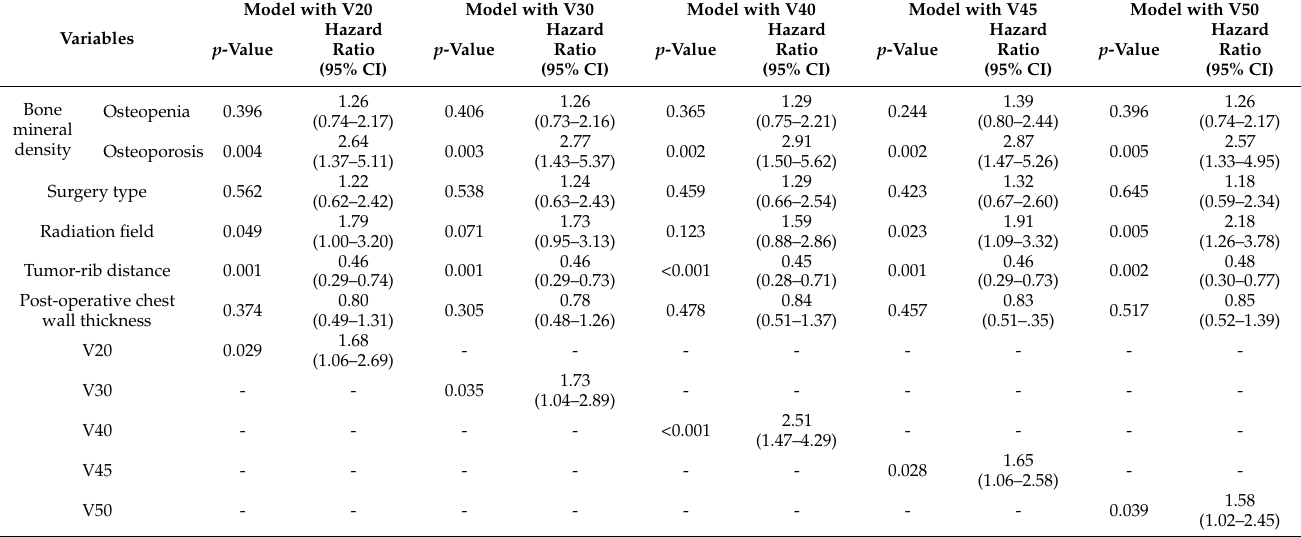
Figure 2. Cumulative incidence of radiation-induced rib fracture (RIRF) according to tumor-rib distance ( A ), postoperative chest wall thickness ( B ), V20 ( C ), V30 ( D ), V40 ( E ), V45 ( F ), and V50 ( G ).